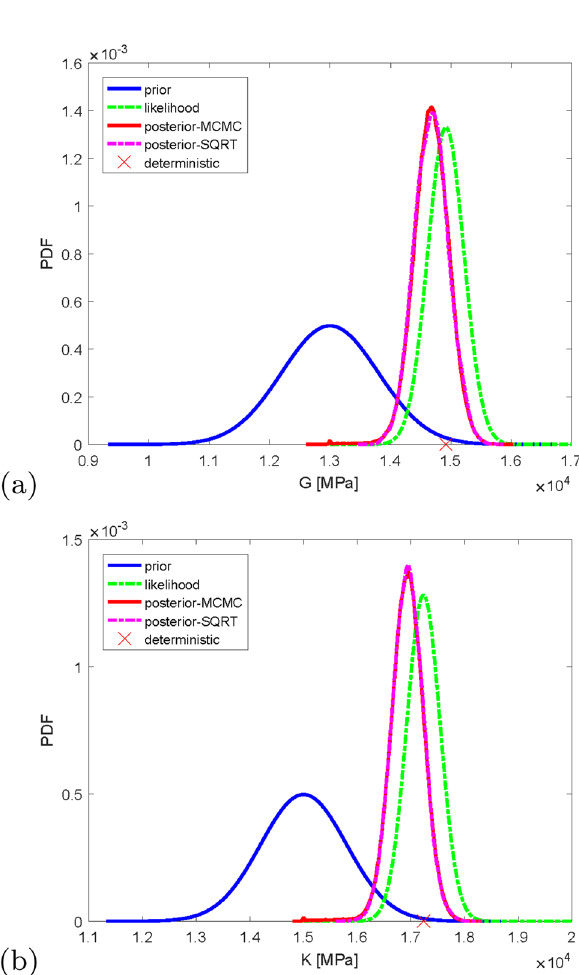
Fig. 8 Posterior PDF for: a shear modulus G computed from sim- ple shear test; b bulk modulus K computed from hydrostatic com- pression test—comparison between the results obtained by GMKF (SQRT updates) versus MCMC via strain energy